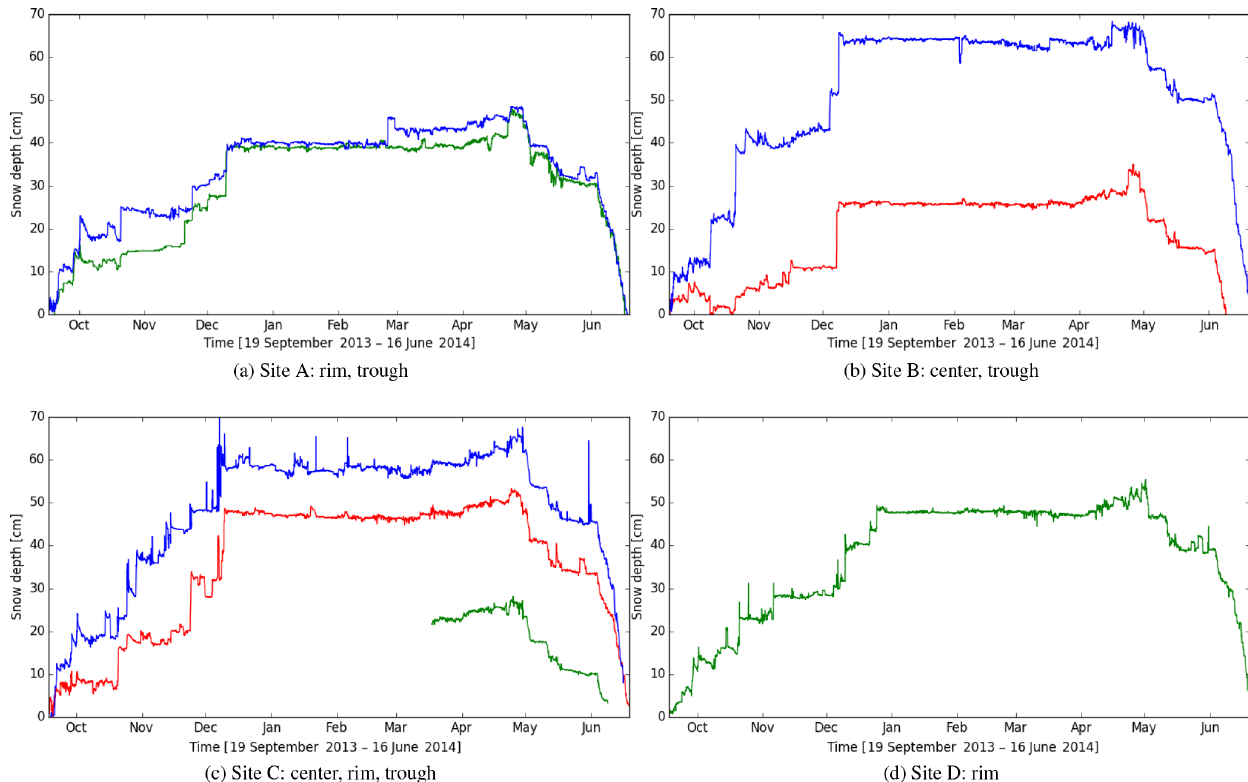
Figure G1. Observed snow depths at different topographic positions: center (in red), rim (in green) and trough (in blue) at our study sites (Hinzman et al.,